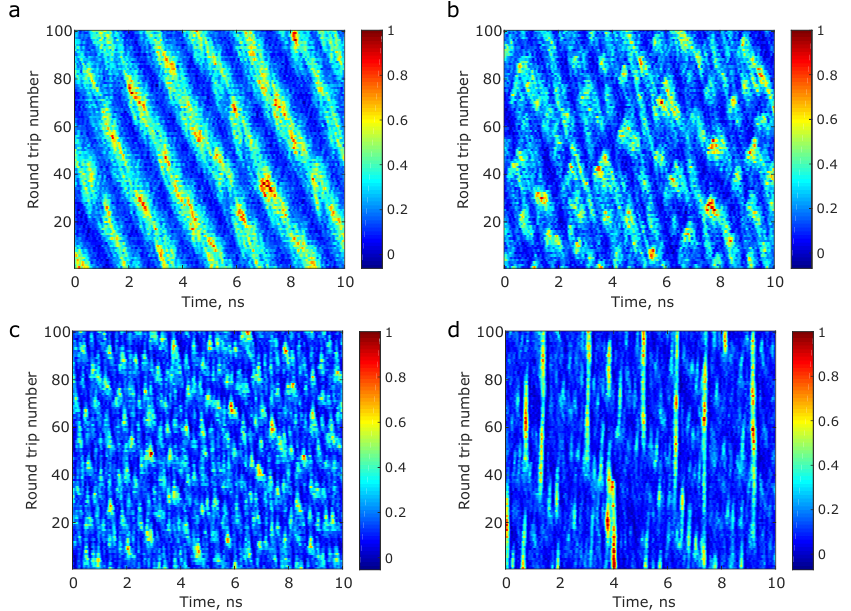
Figure 3. Spatio-temporal regimes of the Raman fibre laser—Spatio-temporal dynamics of a Raman fibre laser operating in the normal dispersion regimes, at different pump powers P p ; ( a ) P p = 1.5 W; ( b ) P p = 2.0 W; ( c ) P p = 3.0 W; and ( d ) P p = 3.25 W.